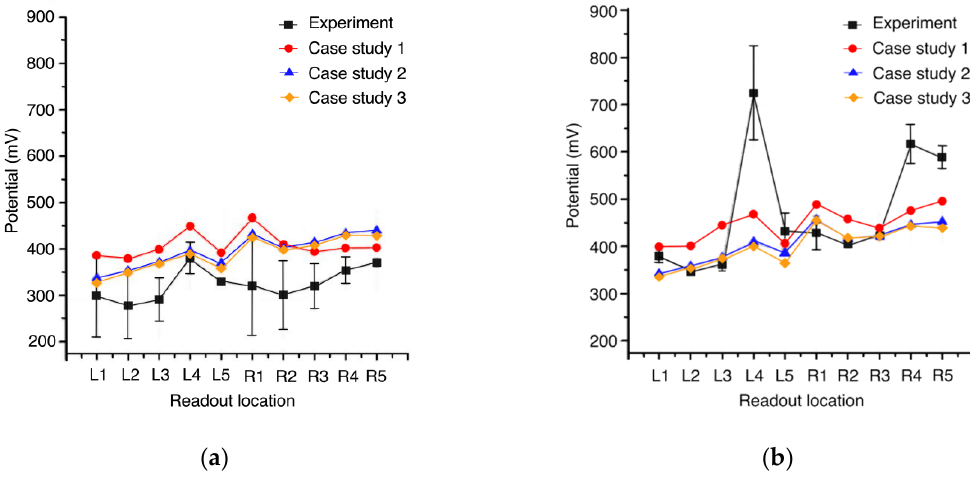
Figure 4. Measured and simulated electric potential values. Values are shown on readout locations L1–L5 of the raster followed by readout locations R1–R5 of the raster, each at a depth of ( a ) 5 mm and ( b ) 8 mm within the stimulated porcine femur.